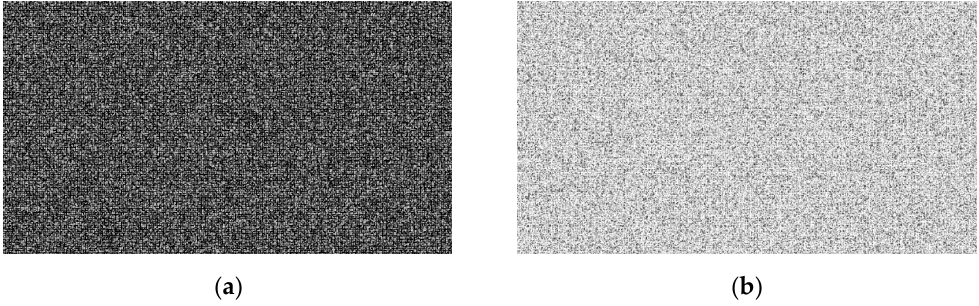
Figure 7. Projected image with random scattered particles: ( a ) low grayscale; ( b ) high